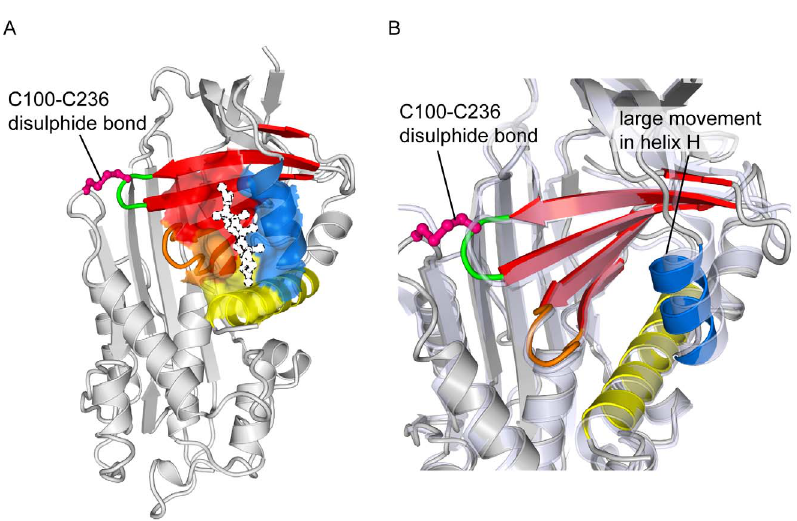
Figure 5. CBG-S100C-V236C-T349R structure. (A) Under non-reducing conditions, residues 100 and 236 form a disulphide bridge. Ligand binding pocket elements are identified by the same colour scheme as Figure 3. In this figure, cortisol from a previous structure (PDB 2VDY [19]) was superimposed on our unliganded structure (PDB 4C41, this work) to highlight the position of the pocket. It is represented as a white silhouette bound by broken lines. (B) When the disulphide bridge is formed, there is an obvious distortion of the steroid binding pocket, as shown here by superimposing the R-state structures of CBG (pale blue, transparent) and CBG-S100C-V236C-T349R (coloured as in A ).